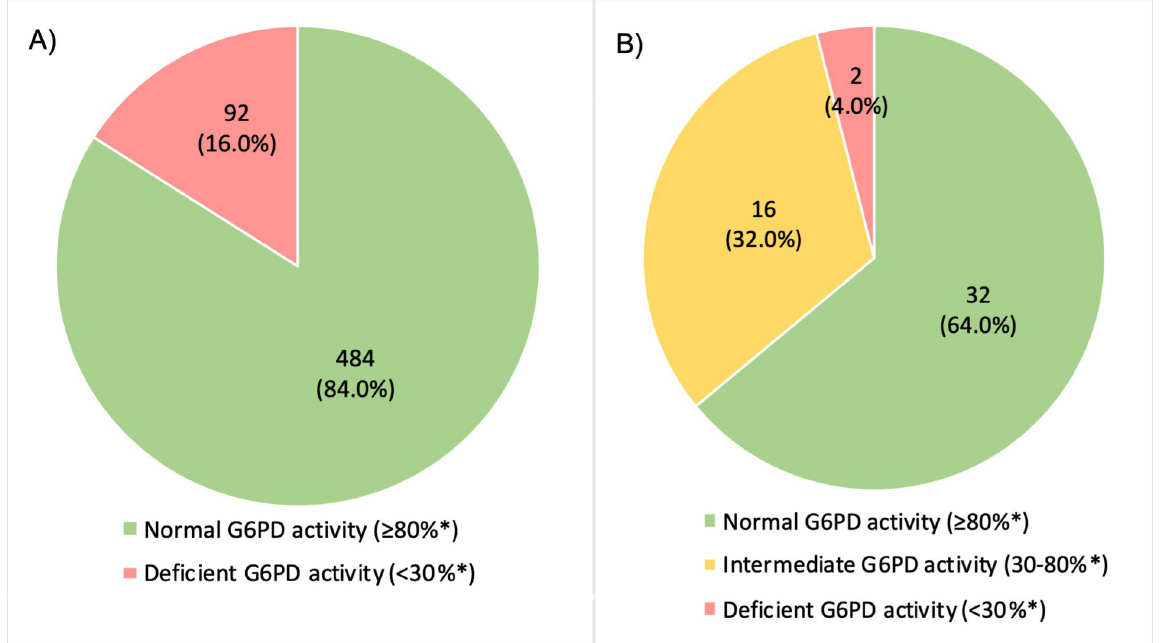
Fig 5. G6PD status of study participants. Number (%) of patients with normal, intermediate and deficient levels of G6PD activity in A) males tested for G6PD status (N = 576) and B) females tested for G6PD status (N = 50). G6PD = glucose-6-phosphate dehydrogenase. � % residual G6PD activity, measured using CareStart TM rapid diagnostic test for male patients and either CareStart TM Biosensor or STANDARD TM Biosensor test for female patients.